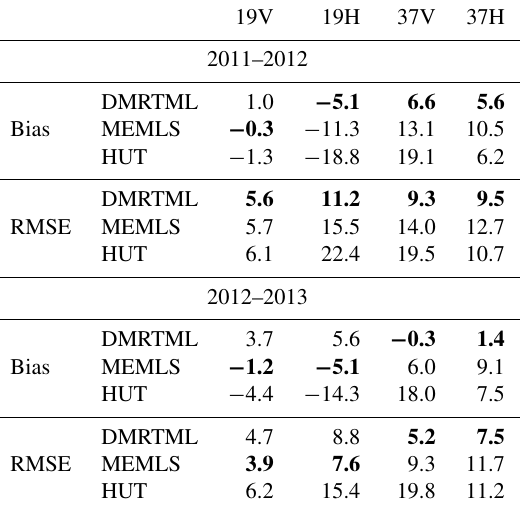
Table 8. Mean bias and RMSE in brightness temperature (K) sim- ulated by DMRT-ML (sticky and non-sticky), MEMLS (empiri- cal and IBA oblate), and HUT (H87, R04, and K10) forced by 189 JIM–microstructure model combinations, with optimal mi- crostructure scale factors from Table 7 applied. Only days in the period from 1 November to 31 March, where all four fre- quency/polarisation measurements were available, were included in the analysis. Bold values indicate the lowest bias/RMSE for each frequency/polarisation.